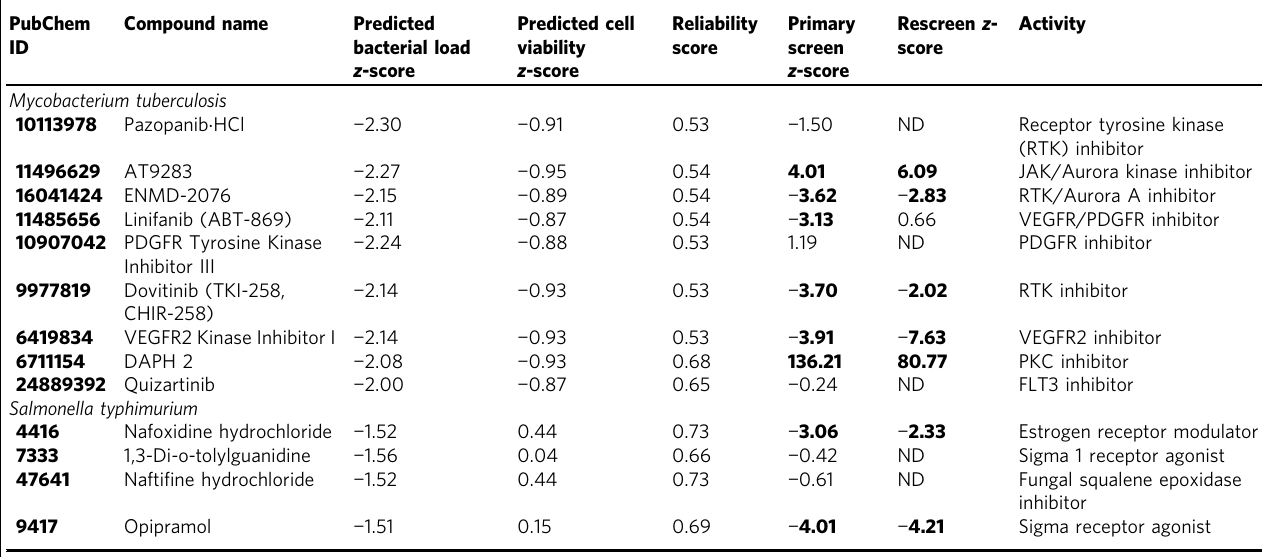
Table 2 Compounds selected from the predictive model output PubChem